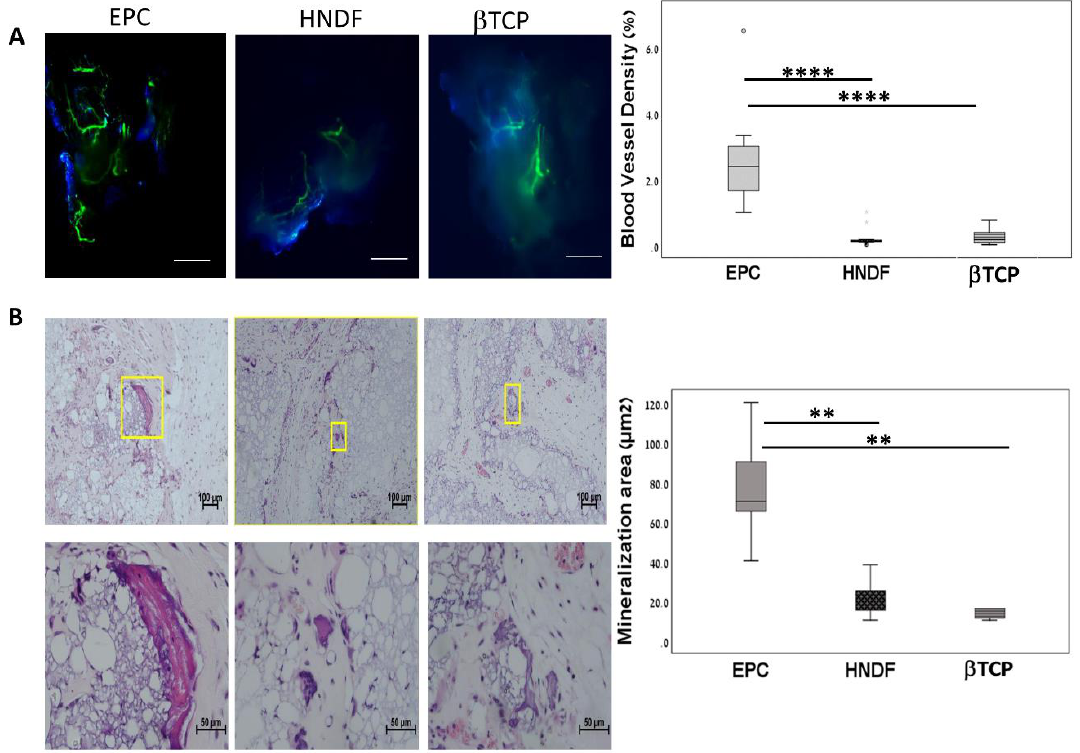
Figure 1. Endothelial progenitor cells (EPCs) stimulate angiogenesis and mineralization in ectopic subcutaneous mouse model. ( A) Ten days after subcutaneous transplantation, blood vessels were stained with FITC dextran and visualized using LSM 510 Zeiss laser confocal system (Zeiss, Germany). Blood vessel density was quantified with IMARIS software (Portland, Oregon, USA). **** p < 0.0001. º means outlier, ★ means extreme outlier . Scale = 50μm. ( B) Eight weeks after transplantation, ectopic mineralization foci were observed in histological slides stained with H&E and quantified with Image Pro software (Rockville, MD, USA). ** p < 0.01. Scale = 100μm (upper panel), 50 μm (lower panel).